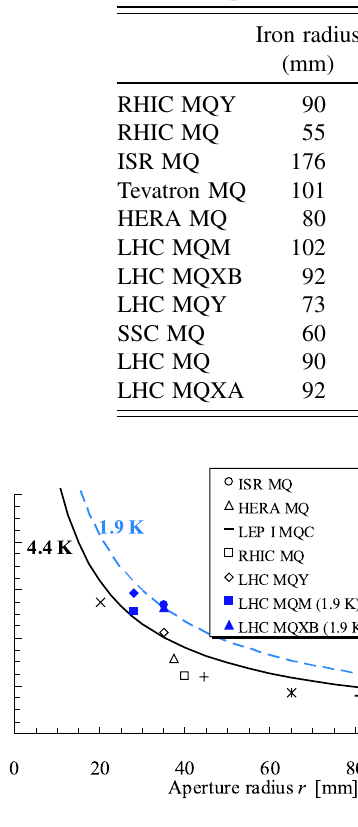
FIG. 26. (Color) Maximum critical gradient as a function of aperture radius for Nb-Ti at 1.9 and 4.2 K for a sector coil of [0 (cid:9) –24 (cid:9) ,30 (cid:9) –36 (cid:9) ] (lines), and critical gradient in some super- conducting quadrupoles